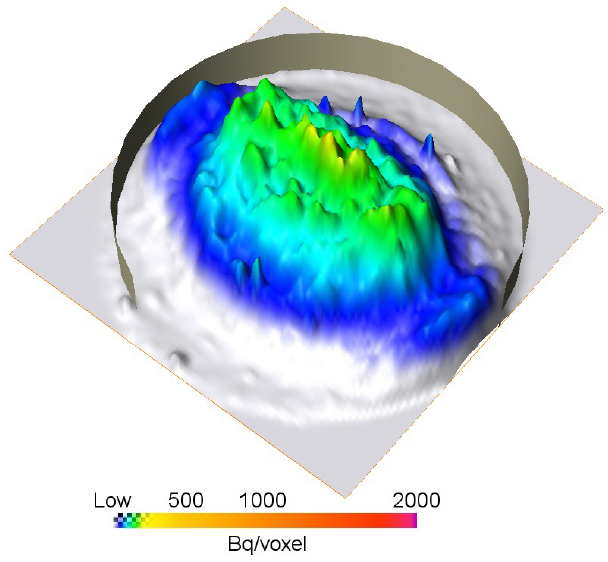
Figure 8. Axial maximum projection of frame 9 (27 days), when the tracer distribution reached the circumference.